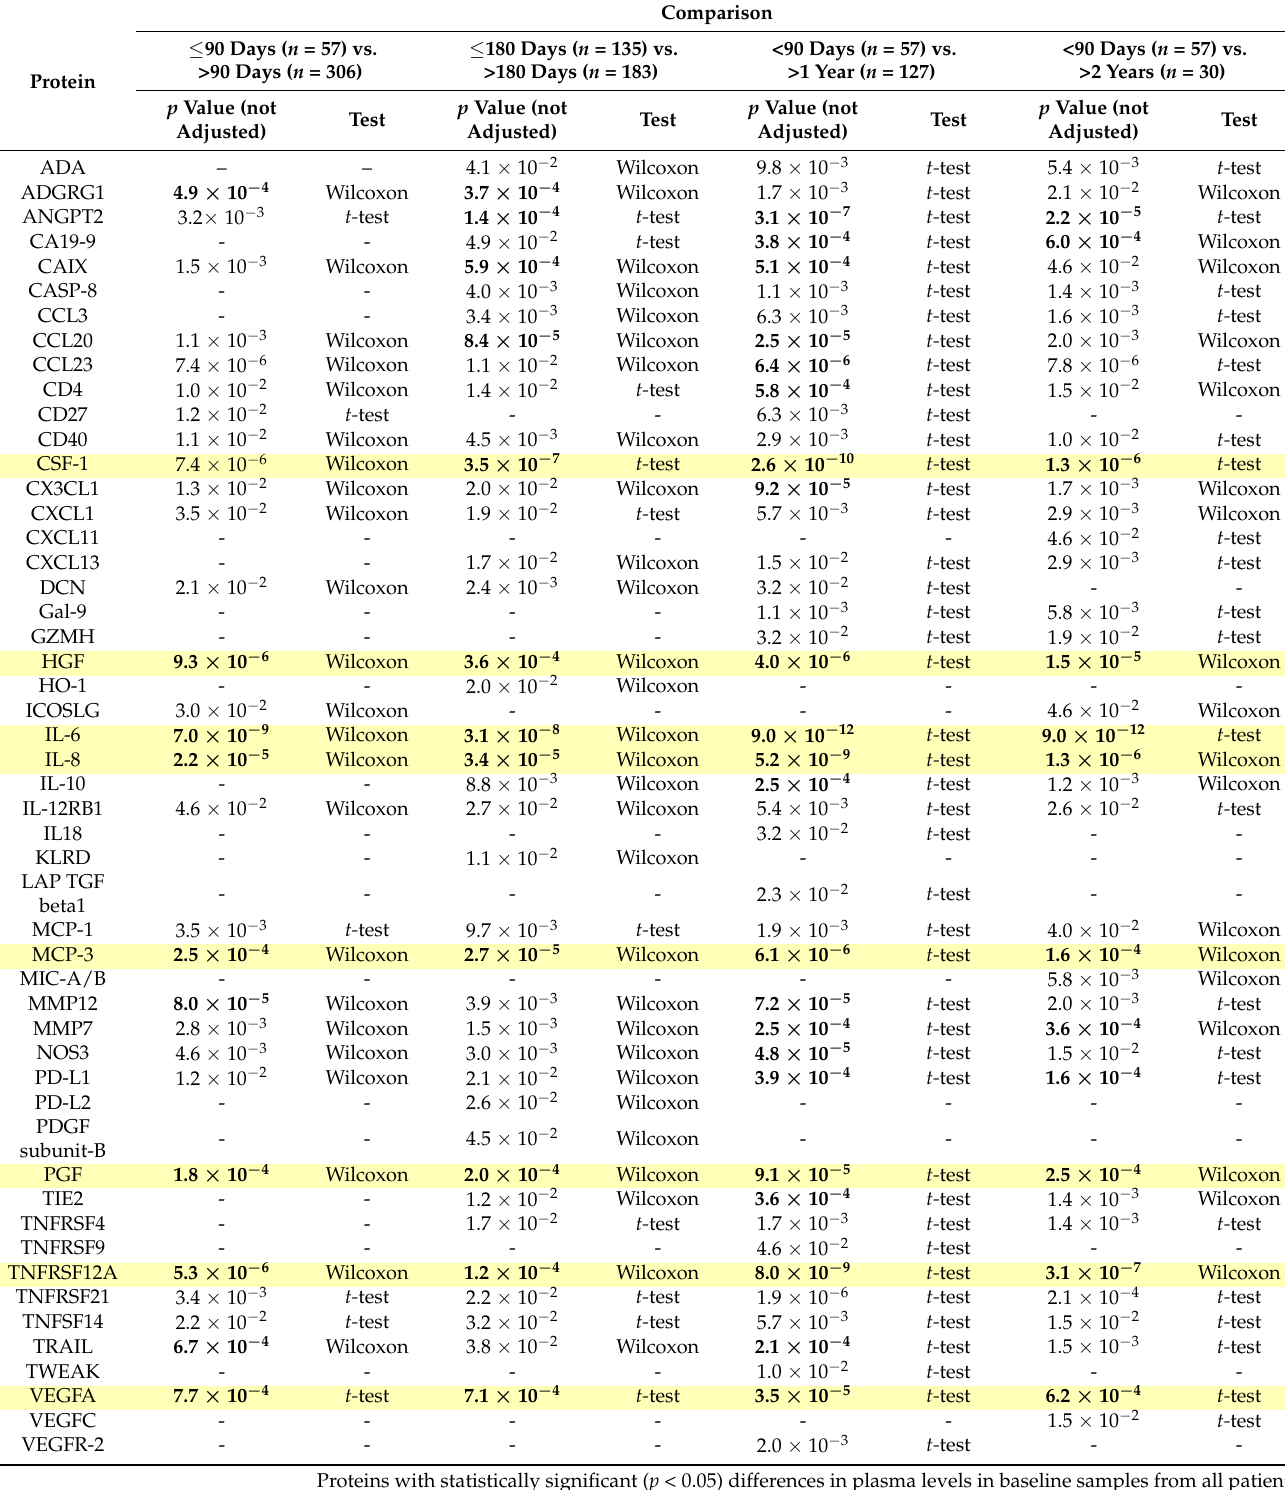
Table 2. Statistically significant proteins in comparisons between survival